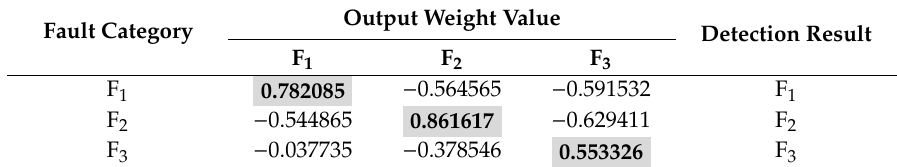
Table 3. Fault detection results under the failure of di ff erent switches in a -phase (inverter frequency = 60 Hz).